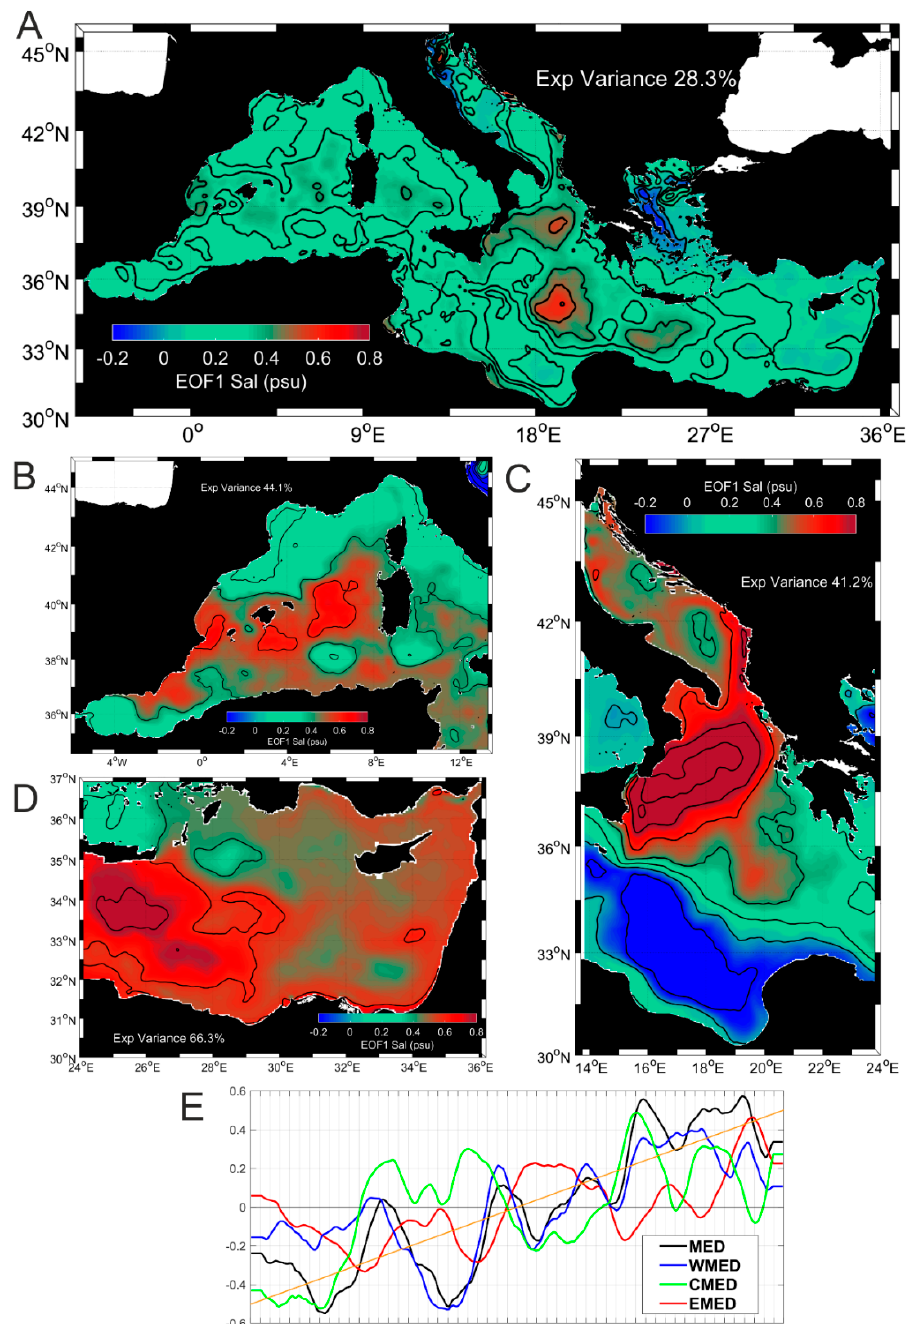
Figure 4. EOF1 of the SSS for the MED ( A ), WMED ( B ), CMED ( C ), and EMED ( D ), and relative PC1s ( E ); the long-term linear trend (orange line) is estimated on the PC1 of MED.